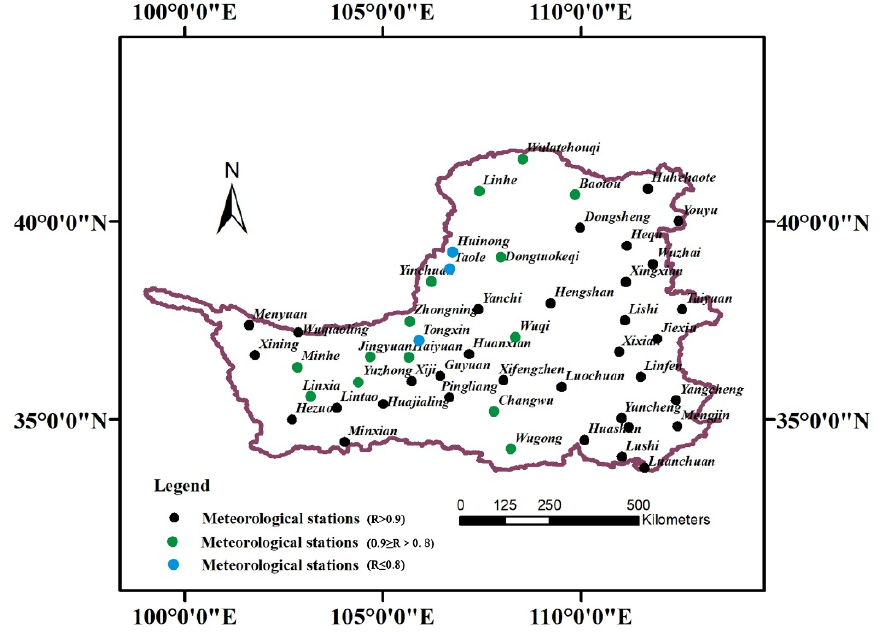
Figure 3. The distribution of the meteorological stations.